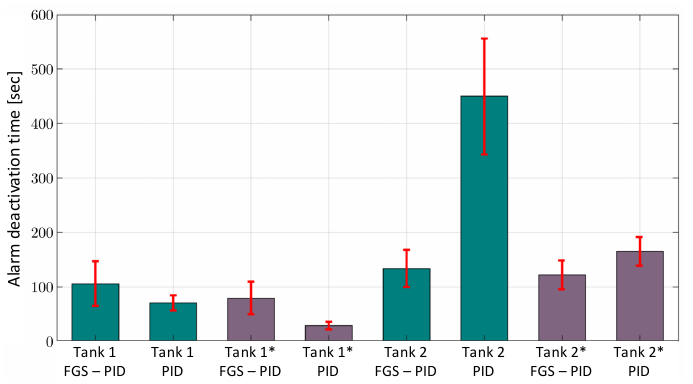
Figure 13. Confidence intervals for the activation time of the fault